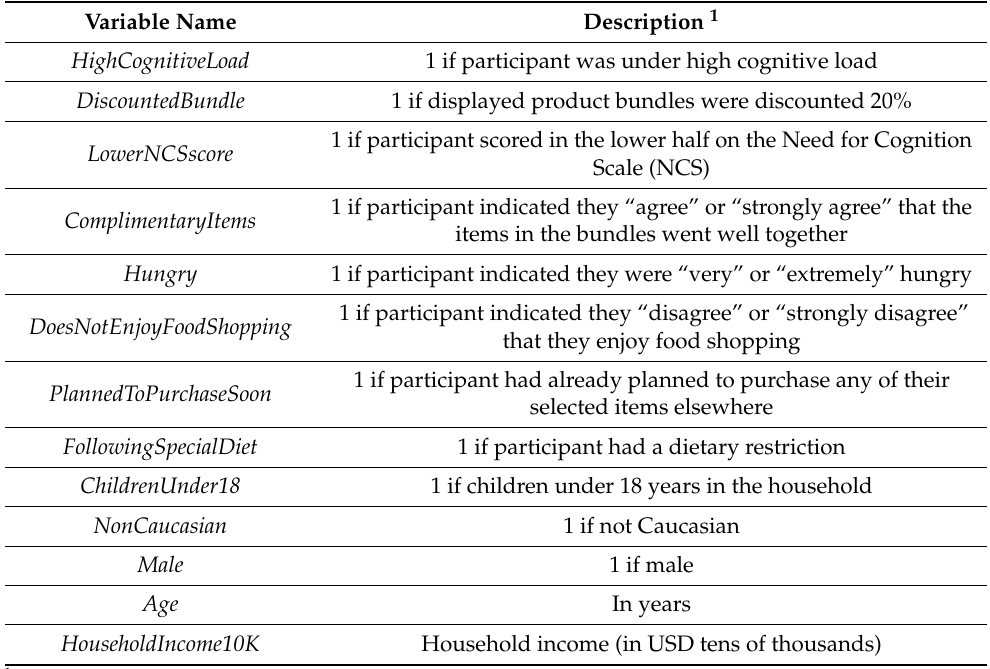
Table 3. Description of